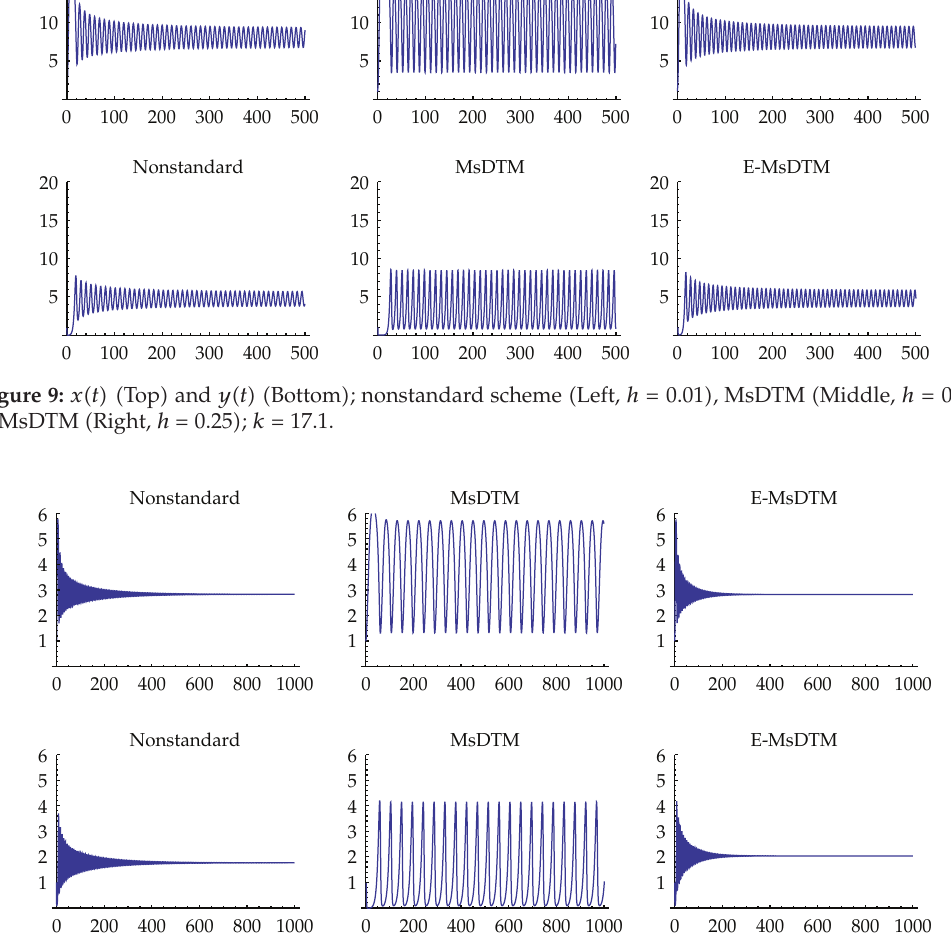
Figure 10: x (cid:4) t (cid:5) (cid:4) Top (cid:5) and y (cid:4) t (cid:5) (cid:4) Bottom (cid:5) ; nonstandard scheme (cid:4) Left, h (cid:8) 0 . 01 (cid:5) , MsDTM (cid:4) Middle, h (cid:8) 0 . 2 (cid:5) , √ E-MsDTM (cid:4) Right, h (cid:8) 0 . 2 (cid:5) ; k (cid:8) 32 2 / 7 − 0 .